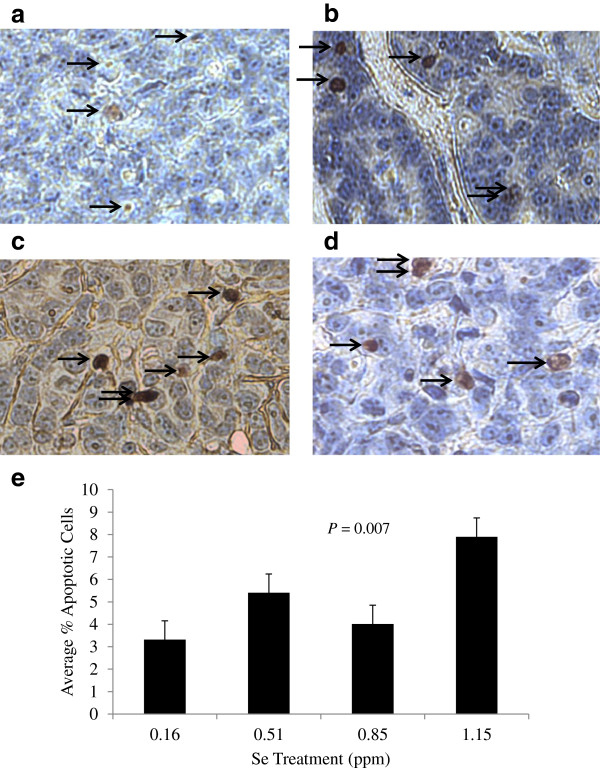
Effect of Se-casein on apoptotic cell number. After 70 d on Se-casein treatment, the 4 largest MCF-7 tumors on each treatment were excised, embedded in wax, and sectioned at 5 μm onto microscope slides.The TUNEL assay was used to identify apoptotic cells and nuclei were counterstained with hematoxylin. a) mouse 13, 0.16 ppm Se. b) mouse 26, 0.51 ppm Se. c) mouse 3, 0.85 ppm Se. d) mouse 15. 1.15 ppm Se. Arrows indicate apoptotic cells. e) Apoptotic cell number was expressed as a percentage of total nuclei, counting 1500–2000 nuclei per sample. Values are means ± SE for each treatment group. The P-value represents the linear effect of dietary Se level.